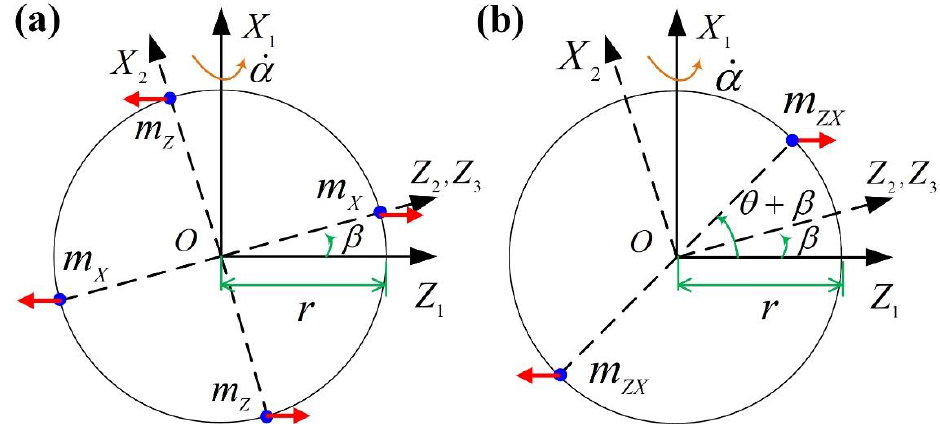
Figure 4. Mechanism of quadratic term error due to ( a ) unequal inertia and ( b ) inertia product. The output error caused by centrifugal force ( I X 2 − I Z 2 ) β